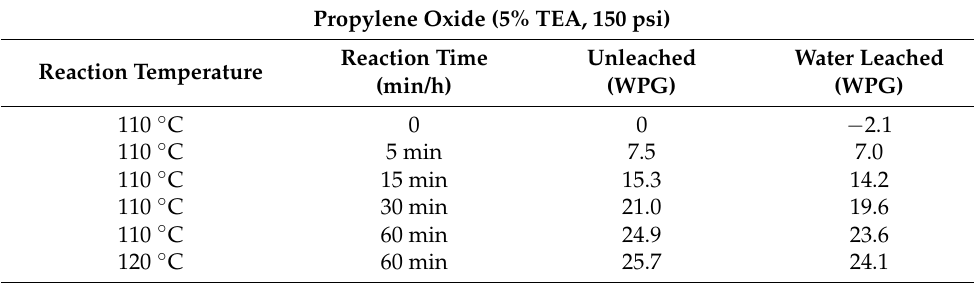
Table 2. Weight percent gain of PO modified wood fiber before and after water leaching.